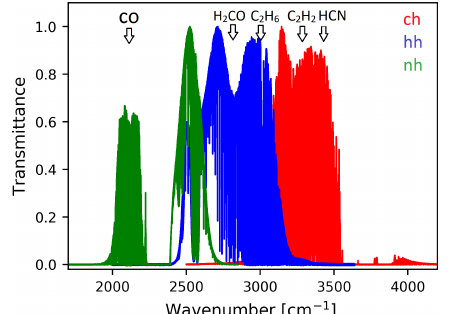
Figure 1. Normalized spectra (ch, hh, and nh) with three different filters used for CO, C 2 H 2 , C 2 H 6 , H 2 CO, and HCN retrievals at